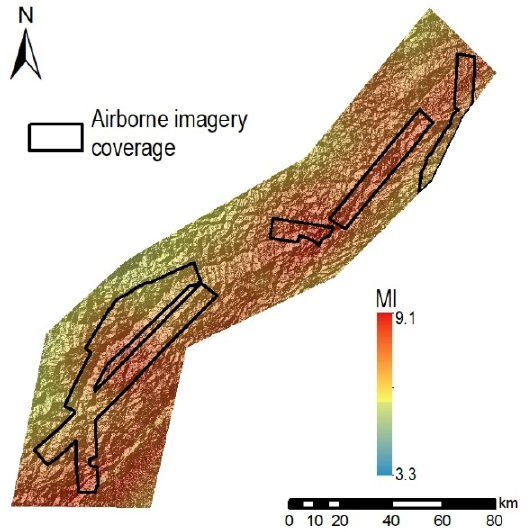
Figure 7. Earthquake macroseismic intensity (MI) distribution of study area.